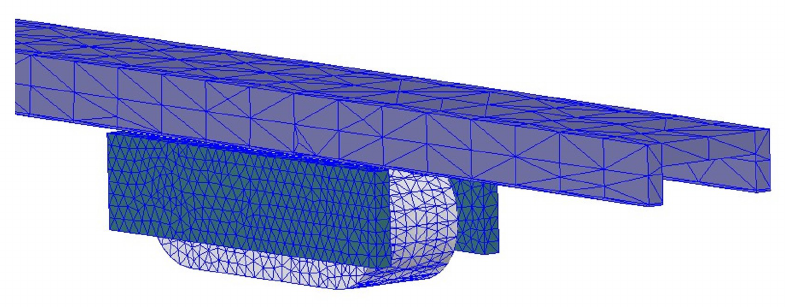
Figure 15. Schematic diagram of mesh generation